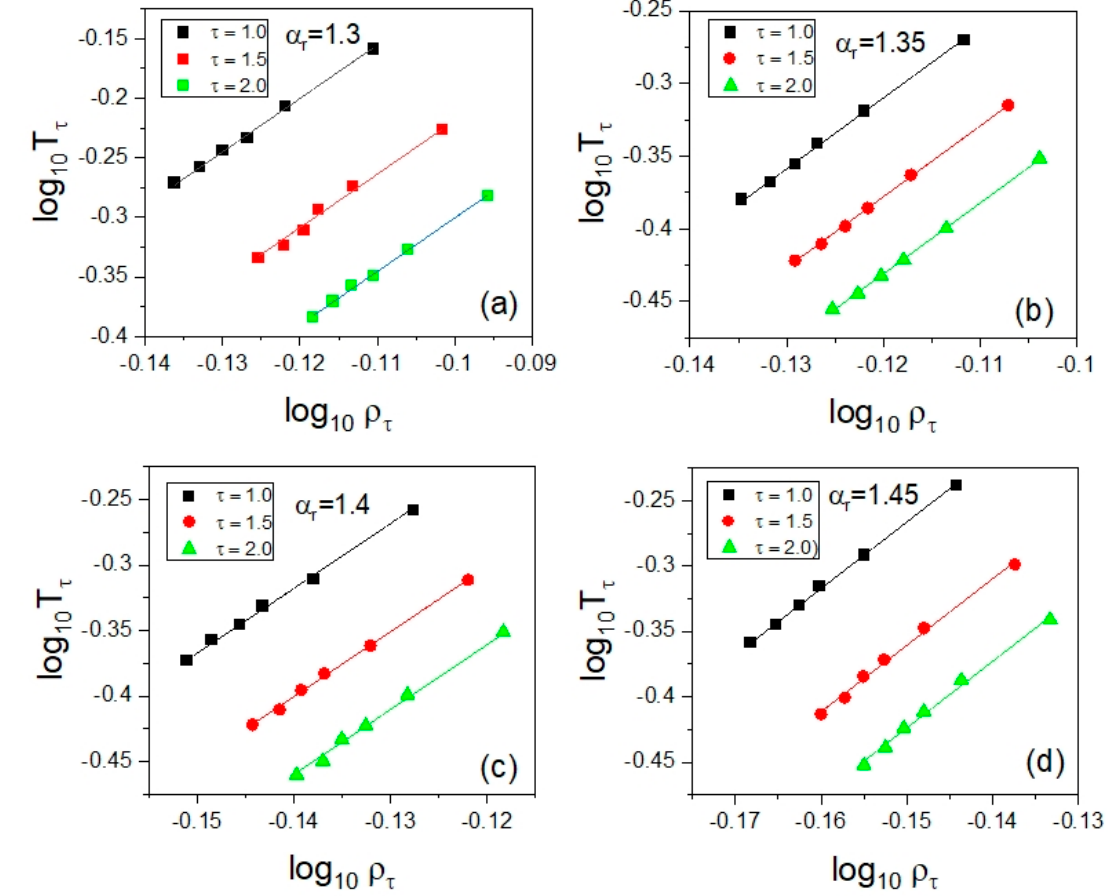
Figure 5. Presentation of the application of the density scaling criterion given by Equation (2) to the evaluation of the values of the scaling exponent γ based on the isochronal log–log dependences of T on ρ for each tested anisotropy aspect ratio α r in the GB model, which is shown in the separate panels for different values of α r : ( a ) 1.30, ( b ) 1.35, ( c ) 1.40, and ( d ) 1.45, respectively. The isochrones are determined at the selected constant values of the translational relaxation times τ in the supercooled liquid state.